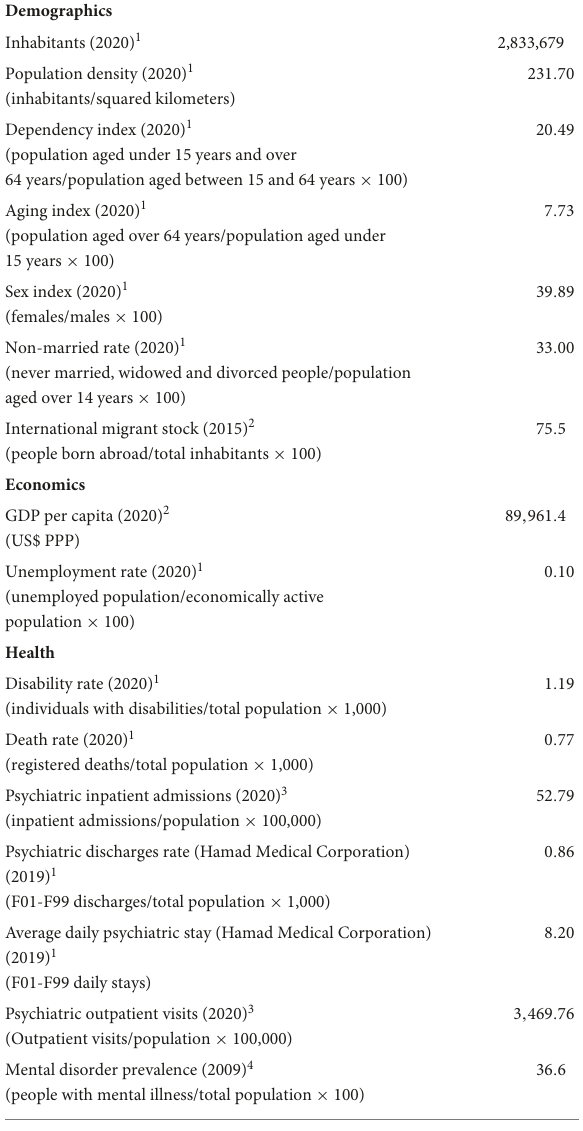
TABLE 1 Sociodemographic description of